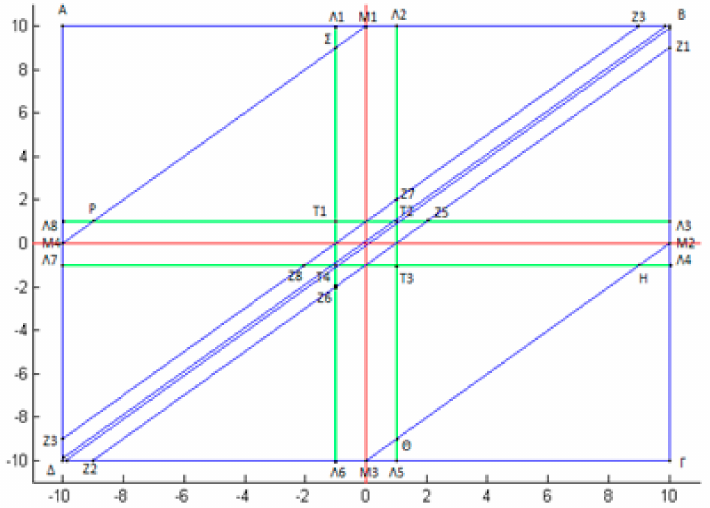
Figure 1. Geometric representation of all pairs of finite precision error mantissae ( x , y ) . Since these pairs do not belong to the cross Λ 1 Λ 2 T 2 Λ 3 Λ 4 T 3 Λ 5 Λ 6 T 4 Λ 7 Λ 8 T 1 Λ 1 , the corresponding joint probabil- ity function is restricted within J = ( A Λ 1 T 1 Λ 8 A ) ∪ ( B Λ 3 T 2 Λ 2 B ) ∪ ( ΓΛ 5 T 3 Λ 4 Γ ) ∪ ( ∆Λ 7 T 4 Λ 6 ∆ )